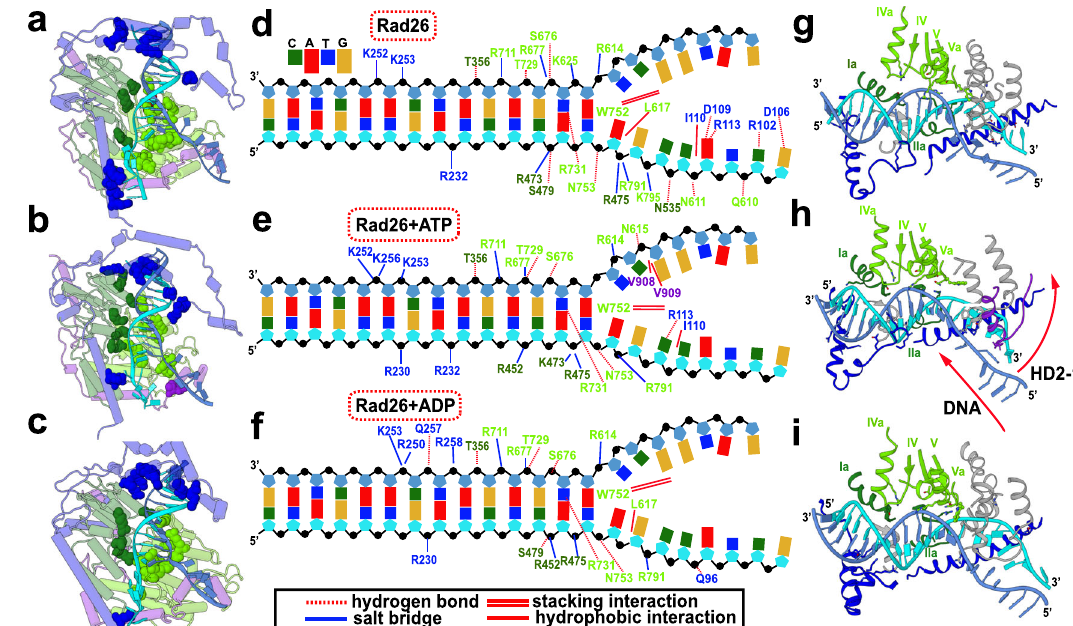
Fig. 3 Nucleotide binding alters Rad26 – DNA interactions. ( a – c ) Rad26 with highlighted Rad26 – DNA contacts in ( a ), apo state; ( b ), ATP state; ( c ), ADP state. Rad26 is shown in cylindrical representation and colored by domains. The side chains of residues participating in DNA binding are shown as spheres and colored by domain — NTD in blue, RecA1 in dark green, RecA2 in light green and CTD in purple. ( d – f ), Schematic detailing the persistent contacts between Rad26 and DNA in ( d ), apo state; ( e ), ATP state; ( f ), ADP state. Residue labels are colored by domain. DNA phosphate groups are shown as black spheres. ( g – i ) Primary Rad26 – DNA interactions in ( g ), apo state; ( h ), ATP state; ( i ), ADP state. Location of ATPase motifs on RecA1 and RecA2 are shown in dark green and light green,